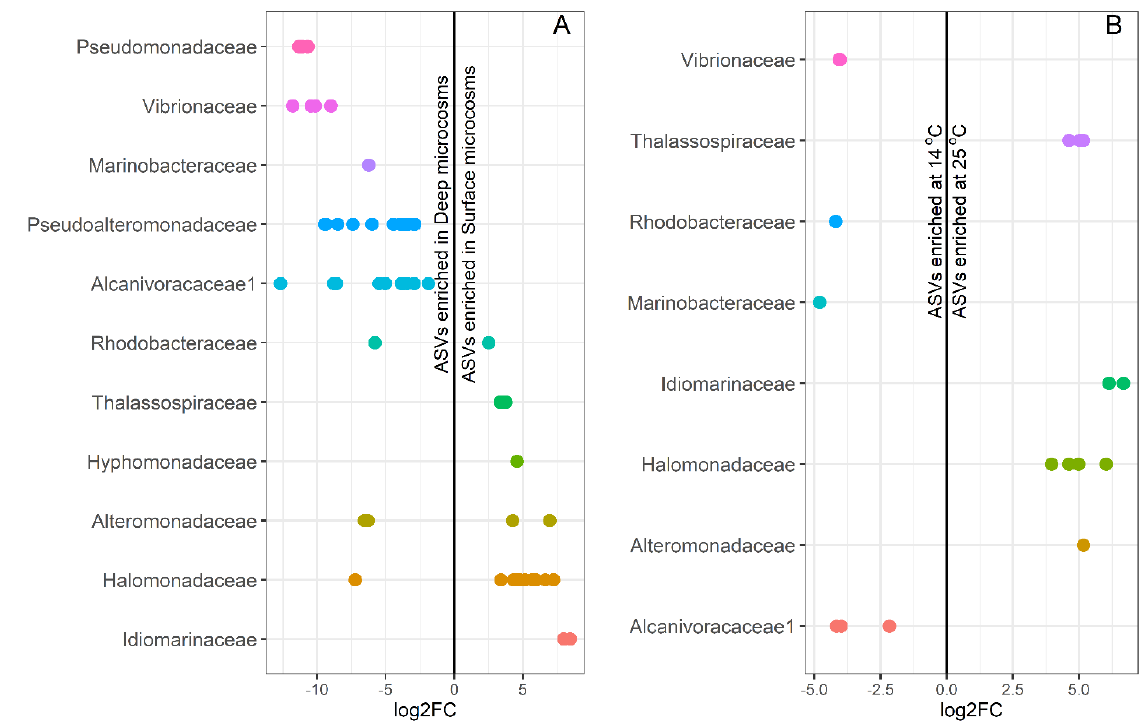
Figure 5. ASVs strongly influenced by depth ( A ) and temperature ( B ) based on DESeq2 analysis. Log2FC is the logarithmic fold change of taxa abundance between two conditions (Surface–Deep and 14–25 ° C).